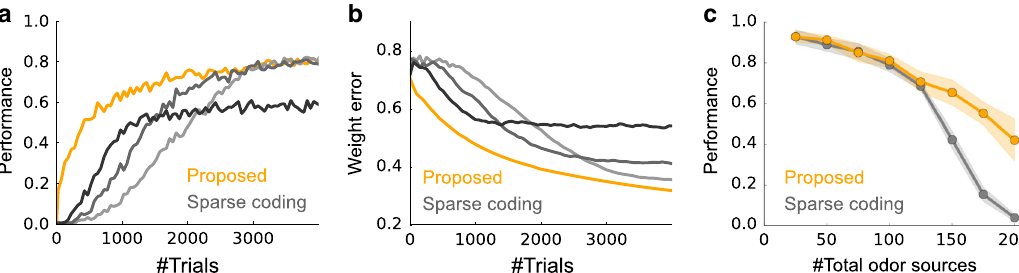
Fig. 4 Performance comparison. a Learning curves for our model (orange) and sparse coding (light gray to black). M = 100 odors, N = 400 glomeruli, and on average, three odors were presented at each trial. See subsection “ Performance evaluation “ in the Methods section for details. The learning rates of the sparse coding model, η w , were 0.3, 0.5, and 1.0 from light gray to black. b Same as a , but the performance was evaluated by the error in the weight. c Performance (after learning from 4000 trials) of the proposed Bayesian model (orange) and the sparse coding model (gray) versus the number of odors. Shaded regions represent standard deviation over 10 simulations. As in panels a and b , N = 400 glomeruli and three odors were presented on average. Here, η w was fi xed